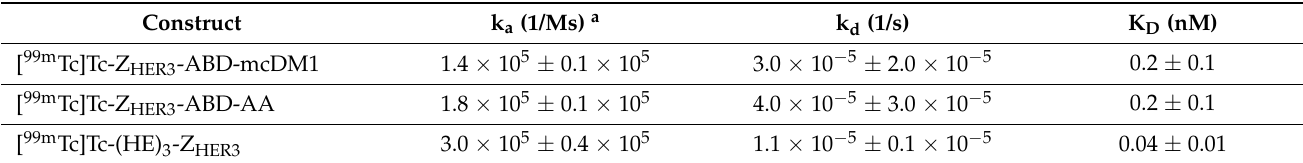
Table 3. Kinetic parameters and equilibrium dissociation constants for the interaction between the constructs and BxPC-3 cells.